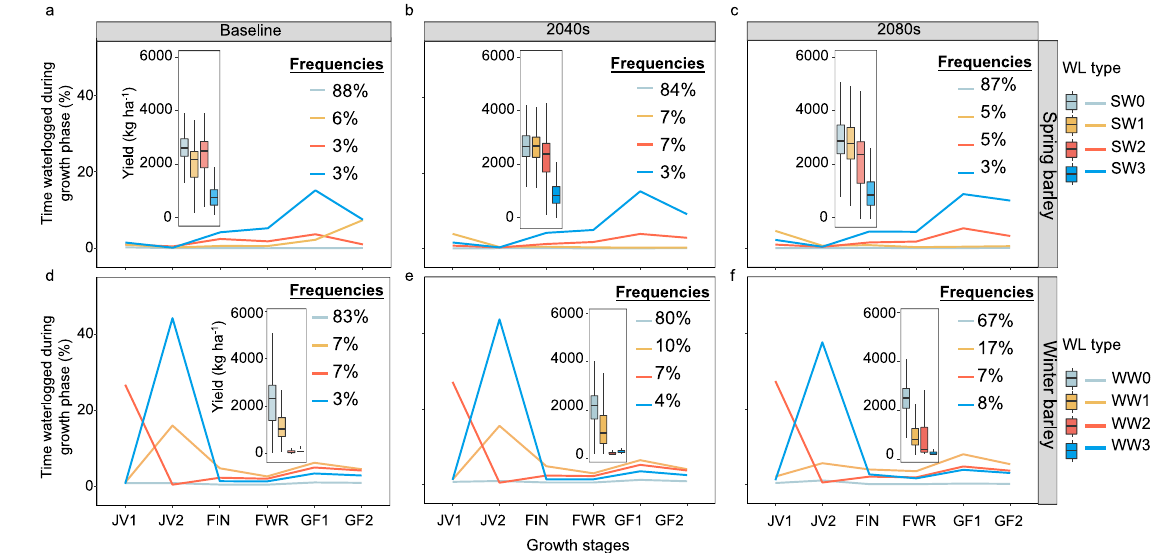
Fig. 3 | Waterlogging (WL) stress patterns and frequencies and grain yields for the baseline (1985 – 2016), 2040 (2030 – 2059) and 2080 (2070 – 2099). Data shown for spring ( a – c ) and winter barley ( d – f ) across sites, sowing times and genotypes. Four key waterlogging stress patterns across sites and genotypes are depicted: stress patterns for spring barley include SW0 (minimal waterlogging); SW1 (low moderate-late waterlogging); SW2 (late-onset moderate waterlogging); SW3 (late-onset severe waterlogging) and winter barley WW0 (minimal water- logging);WW1(lowearly-onsetwaterloggingrelievedlater);WW2(moderateearly- onset waterlogging); WW3 (severe early-onset waterlogging). Boxplots indicate